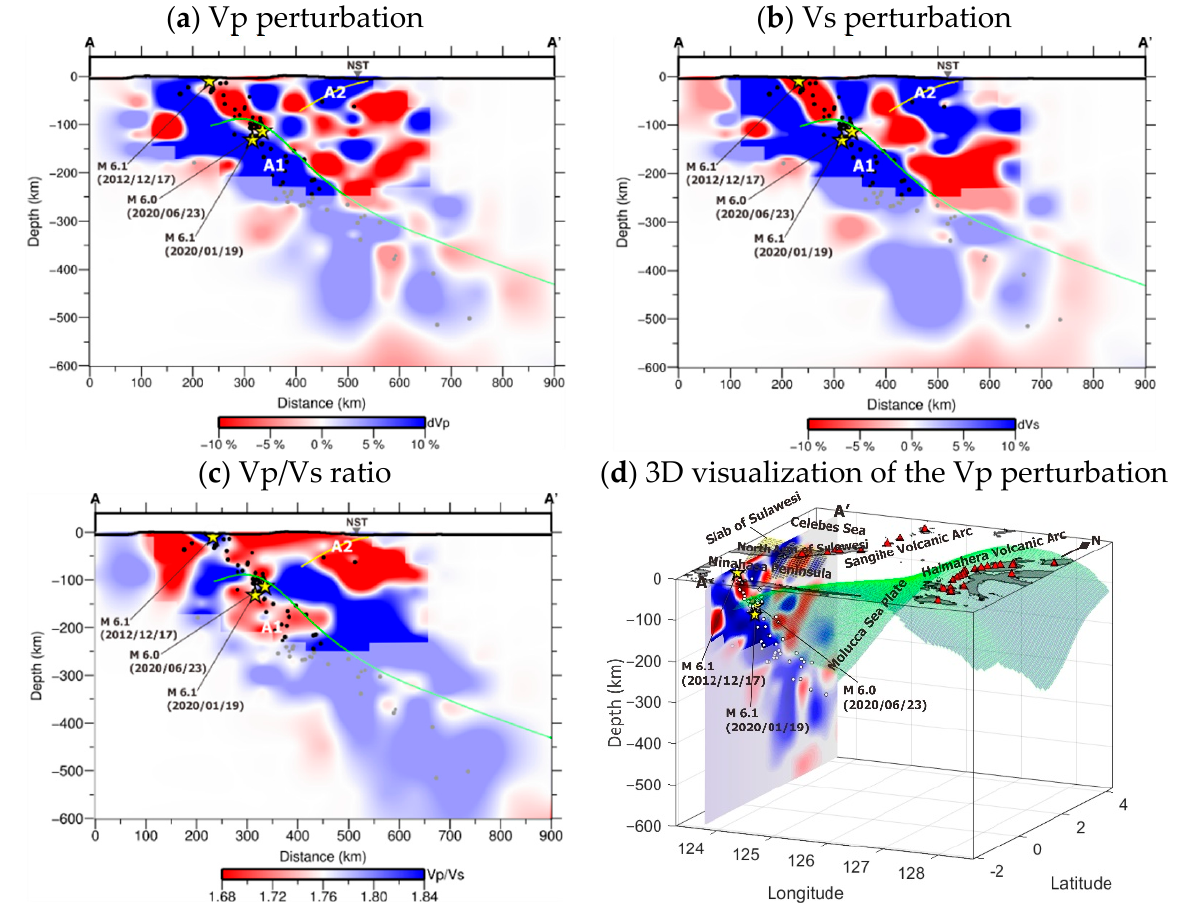
Figure 6. Vertical cross-section of A-A ′ (south–north) of the Molucca Sea Plate, crossing the Minahasa Peninsula, Sulawesi’s north arm, and the Celebes Sea. The red color indicates low velocity and low Vp/Vs ratio, and the blue color indicates high velocity and high Vp/Vs ratio. The A1 and A2 are areas for the interpretation of tomographic inversion results. The black dots signify earthquakes within a radius of 30 km ≤ A-A ′ ≤ 30 km, and the yellow stars are significant earthquakes. The green line and the green three-dimensional surface plot are the slab2 models of the Molucca Sea Plate. The yellow line is the slab2 model of Sulawesi [45]. NST is the North Sulawesi Trench. The red triangles signify volcanoes. The blurred area is an area that is not well-resolved.